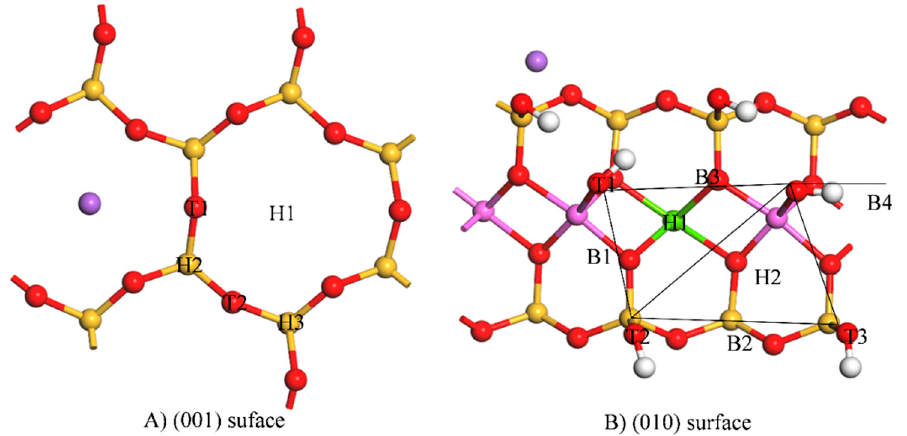
Figure 3. Initial adsorption sites of Cd 2+ on (001) surface ( A ) and (010) surface ( B ). T represents the top position above the oxygen atoms on the surface, H represents the hole position between the oxygen atoms, and B represents the bridge position between the oxygen atoms.